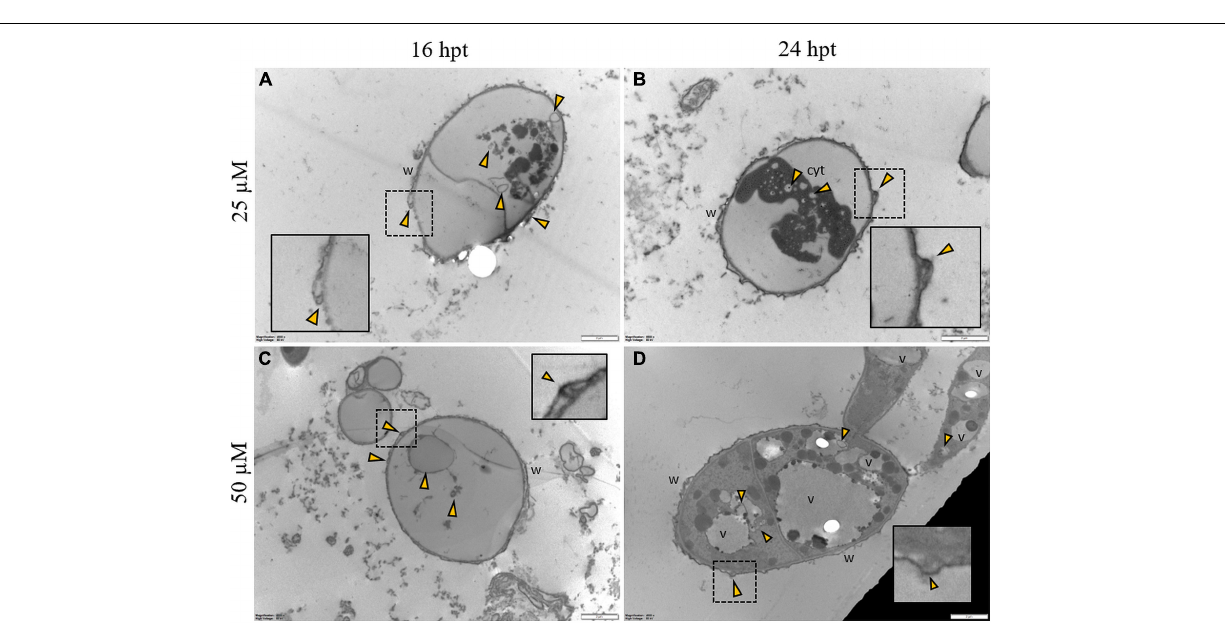
FIGURE 9 | Representative TEM micrographs of Pyricularia oryzae conidia treated with Pep 4Rink 25 µ M (A,B) or 50 µ M (C,D) and observed at 16 or 24 h post treatment (hpt). Regardless of the different treatments, conidia appear empty (A,C) or contain condensed cytoplasm (B) and vesicles ( A-D , yellow arrowheads). In panel (D) a germinating conidium presents abnormal vacuolation. Small vesicles ( A-D , yellow arrowheads) are observed between the two cell wall layers. In insets, areas of interest of panels (A-D) are magnified. Cyt: cytoplasm; v: vacuole, w: wall. Magnification bars correspond to 2 µ